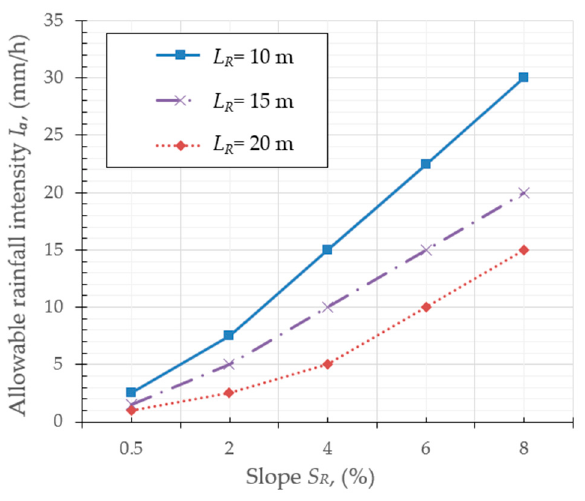
Figure 7. Allowable rainfall intensity I a according to the slope S R and lengths L R . Table 5. Time taken for water flow over the PFC pavement surface ( t p ) for I = 50 mm/h, L R = 10 m, and S R = 2%.